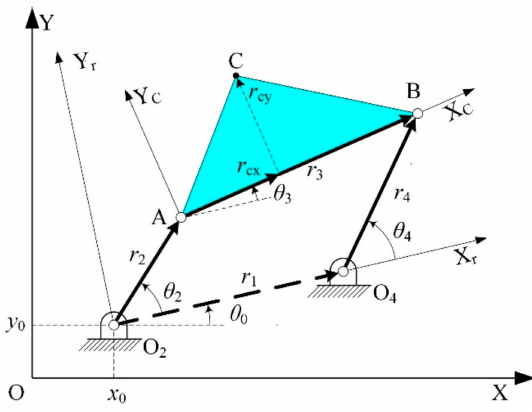
Figure 2. Variables of the four-bar